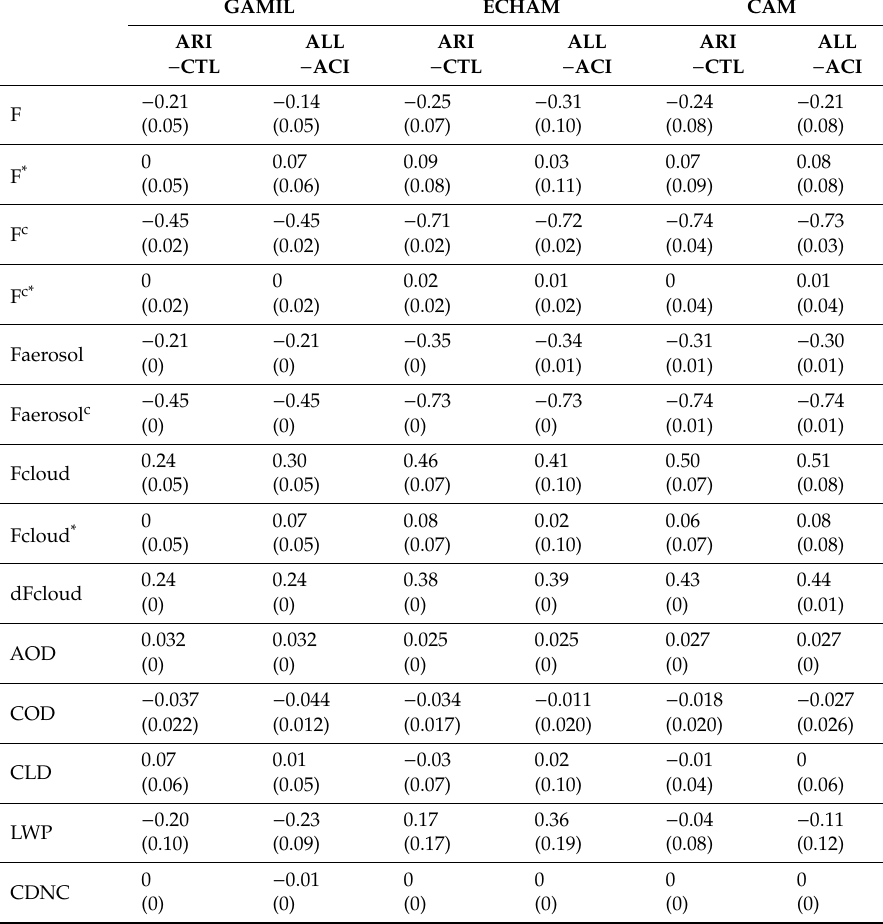
Table 4. Same as Table 3, but shown are changes from aerosol-radiation interactions (i.e., the ARI experiment minus the CTL experiment and the ALL experiment minus the ACI experiment). GAMIL ECHAM CAM ARI ALL